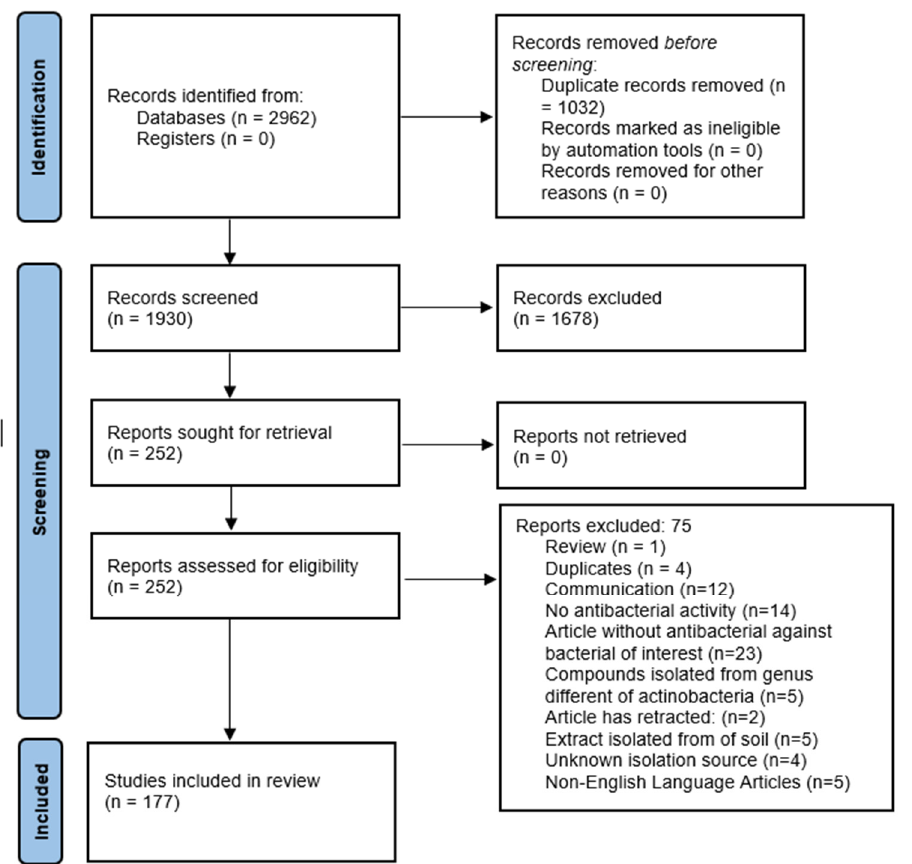
Figure 1. PRISMA flow diagram. Flowchart of systematic literature search according to PRISMA guidelines. Modified from [24]. The systematic review was done following the PRISMA guidelines, the complete checklist can be reviewed in Supplementary Table S1.